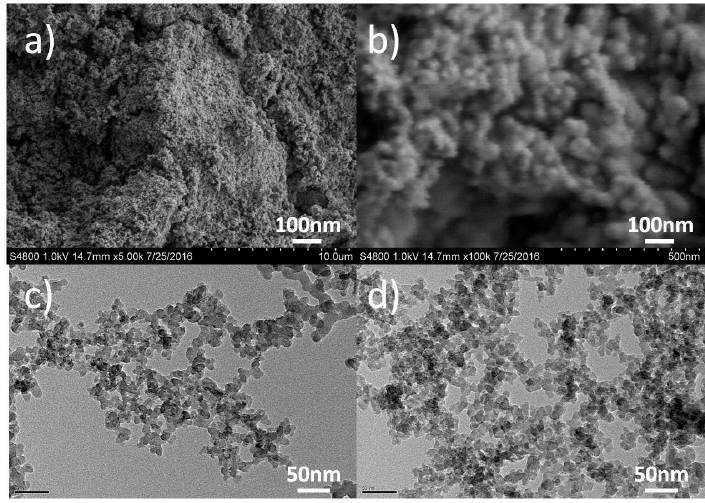
Figure 2. ( a , b ) SEM and ( c , d ) TEM images of PDMS-SiO 2 .